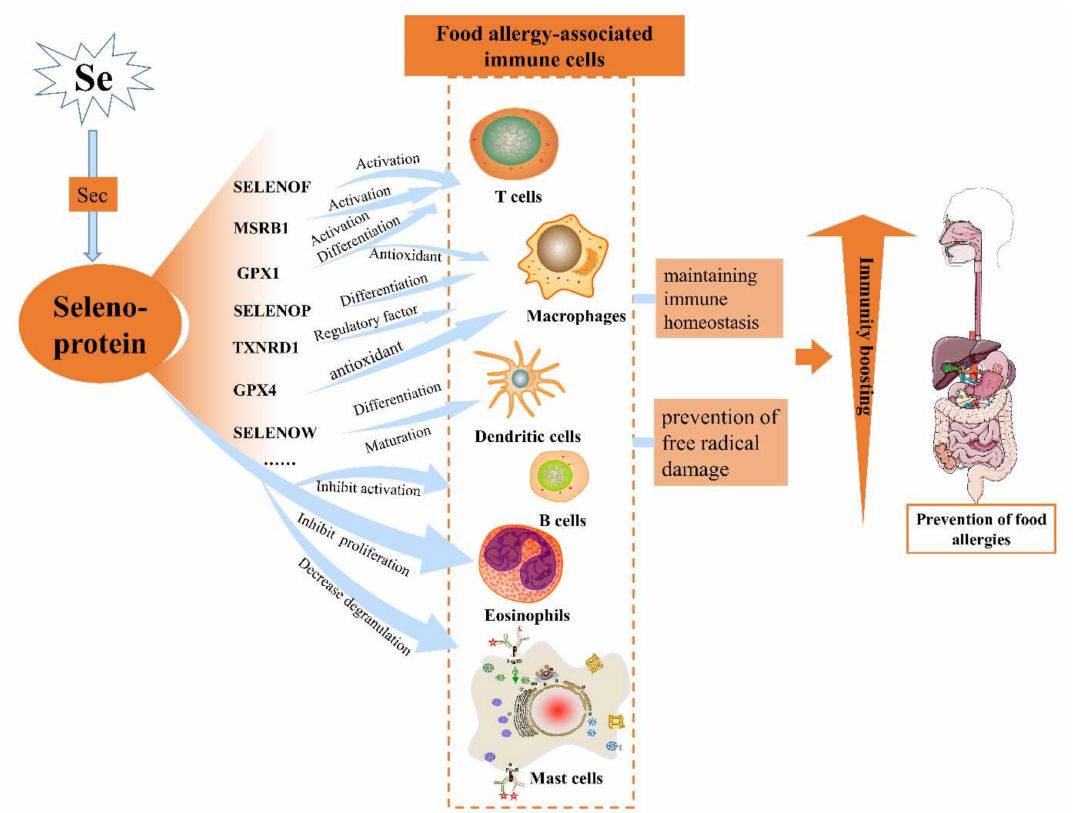
Figure 1. The mechanism of selenoprotein interaction with immune